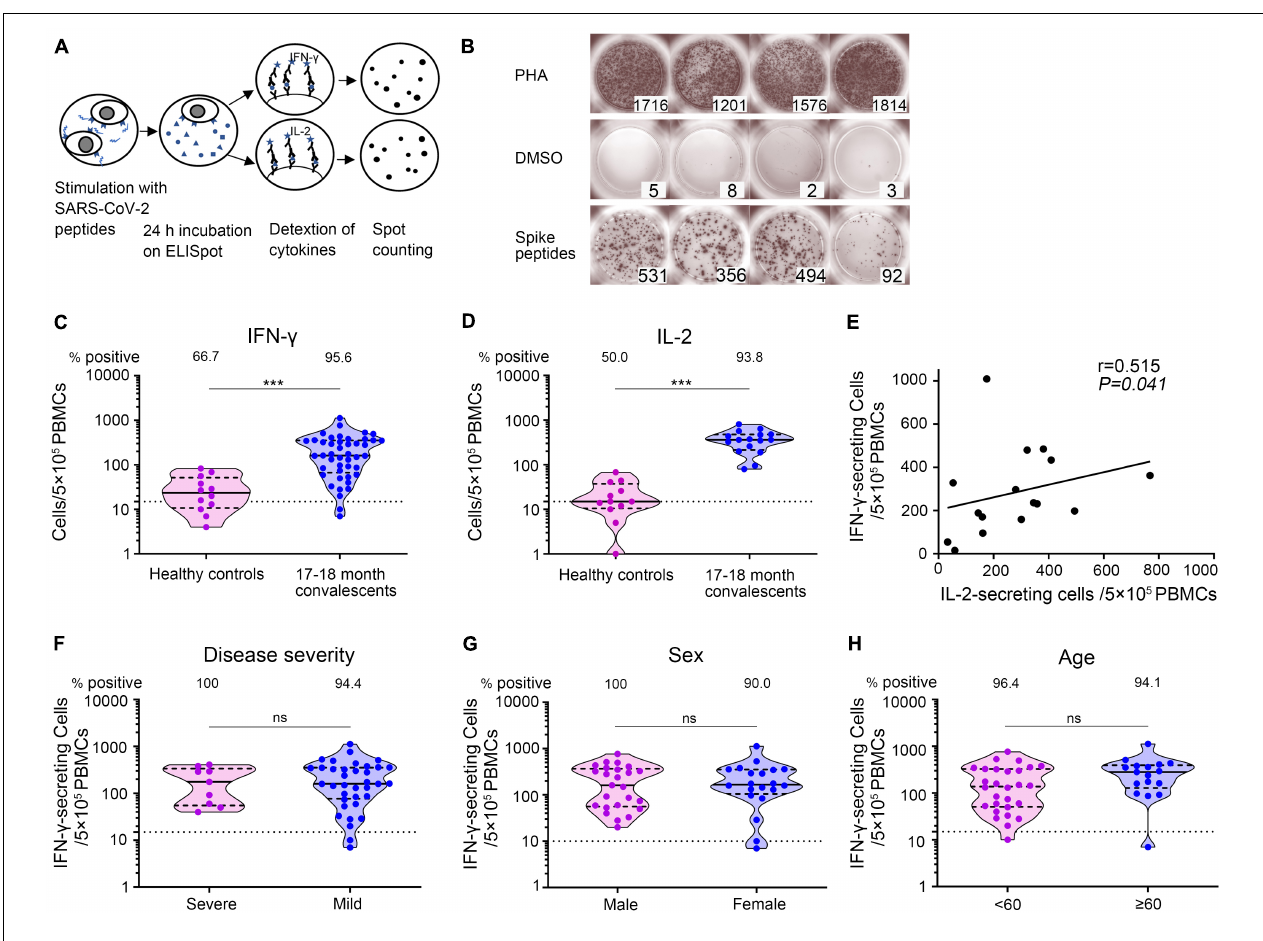
FIGURE 6 | SARS-CoV-2-specific T-cell responses 17–18 months after COVID-19 onset. (A) Schematic of memory T-cell ELISpot assay. (B) Representative ELISpots from COVID-19 convalescent patients 17–18 months after illness onset with SARS-CoV-2 spike S1 and S2 mixture peptides as the specific stimulus, DMSO as the negative control, and PHA as the positive control. The numbers in the lower right corner represented the spots counting. (C,D) The total number of SARS-CoV-2-specific IFN- γ - secreting T cells and IL-2 secreting T cells per 5 × 10 5 PBMCs. Each dot represents an individual patient. Bars represent the median and interquartile range (IQR). Statistical significance was determined using the Mann–Whitney U -test, and represented as *** p < 0.001. (E) Correlation of SARS-CoV-2-specific IFN- γ -secreting T cells and IL-2-secreting T cells 17–18 months after illness onset ( N = 16). A two-sided Spearman rank correlation test was used to evaluate the correlation of the two cytokines. (F–H) IFN- γ -secreting T cells of COVID-19 patients according to disease severity (F) , sex (G) , and age (H) . Multivariate generalized linear models were used to compare the difference between IFN- γ spots and potential factors (i.e., disease severity, sex, and age). The dotted horizontal line represents the threshold for positive in this assay. *** p < 0.001. PBMCs, peripheral blood mononuclear cells; DMSO, dimethyl sulfoxide; PHA,